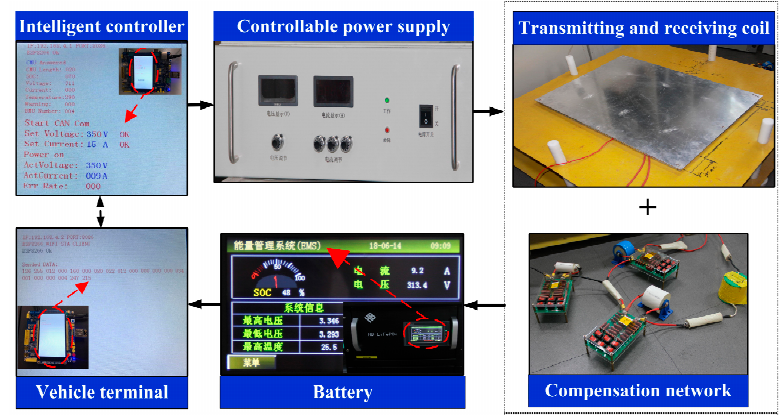
Figure 7. Experimental platform of charging control.